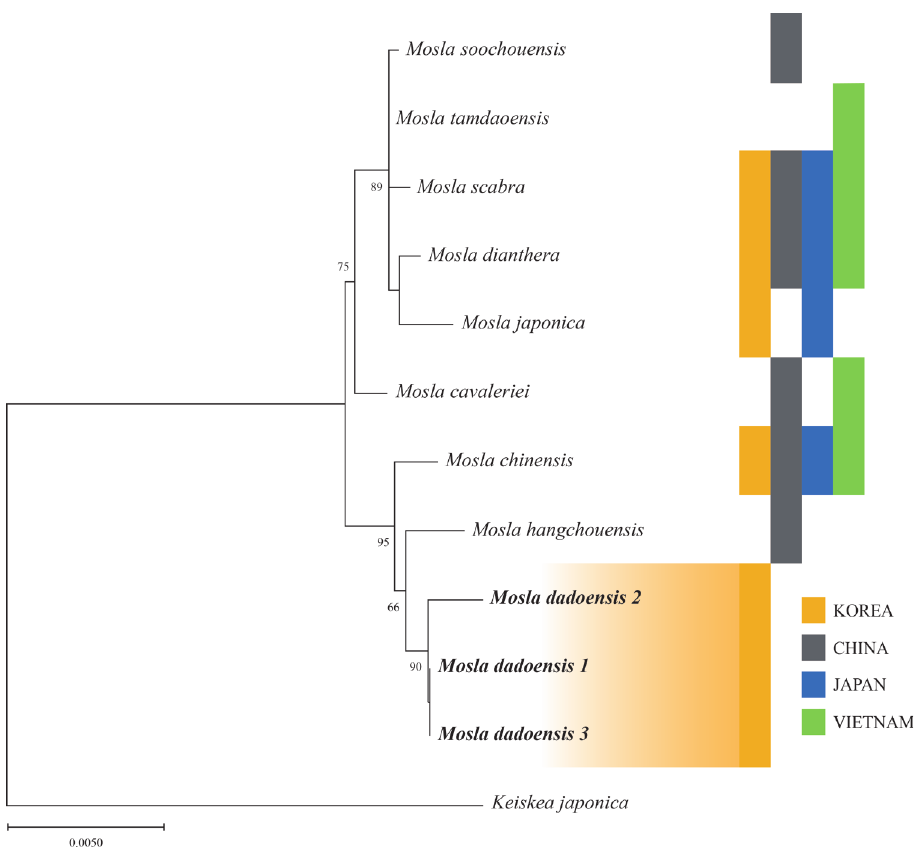
Figure 6. Phylogenetic tree of Mosla dadoensis and related taxa based on concatenated alignments of two nrDNA (ITS, ETS) and three cpDNA regions ( rbc L, mat K, trn L-F). The numbers above branches are bootstrap values (BS > 50%) used in the maximum likelihood method. Distribution information was obtained from Plants of the World Online